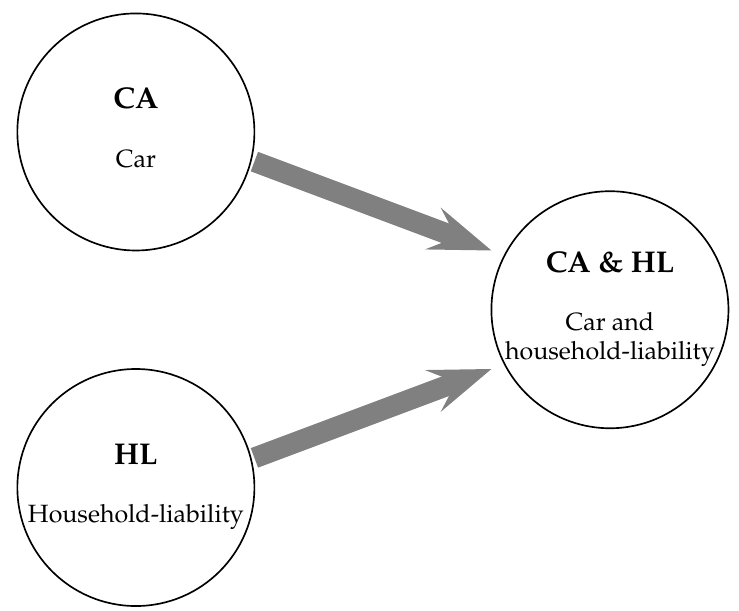
Figure 1. Illustration of the states and transitions considered.